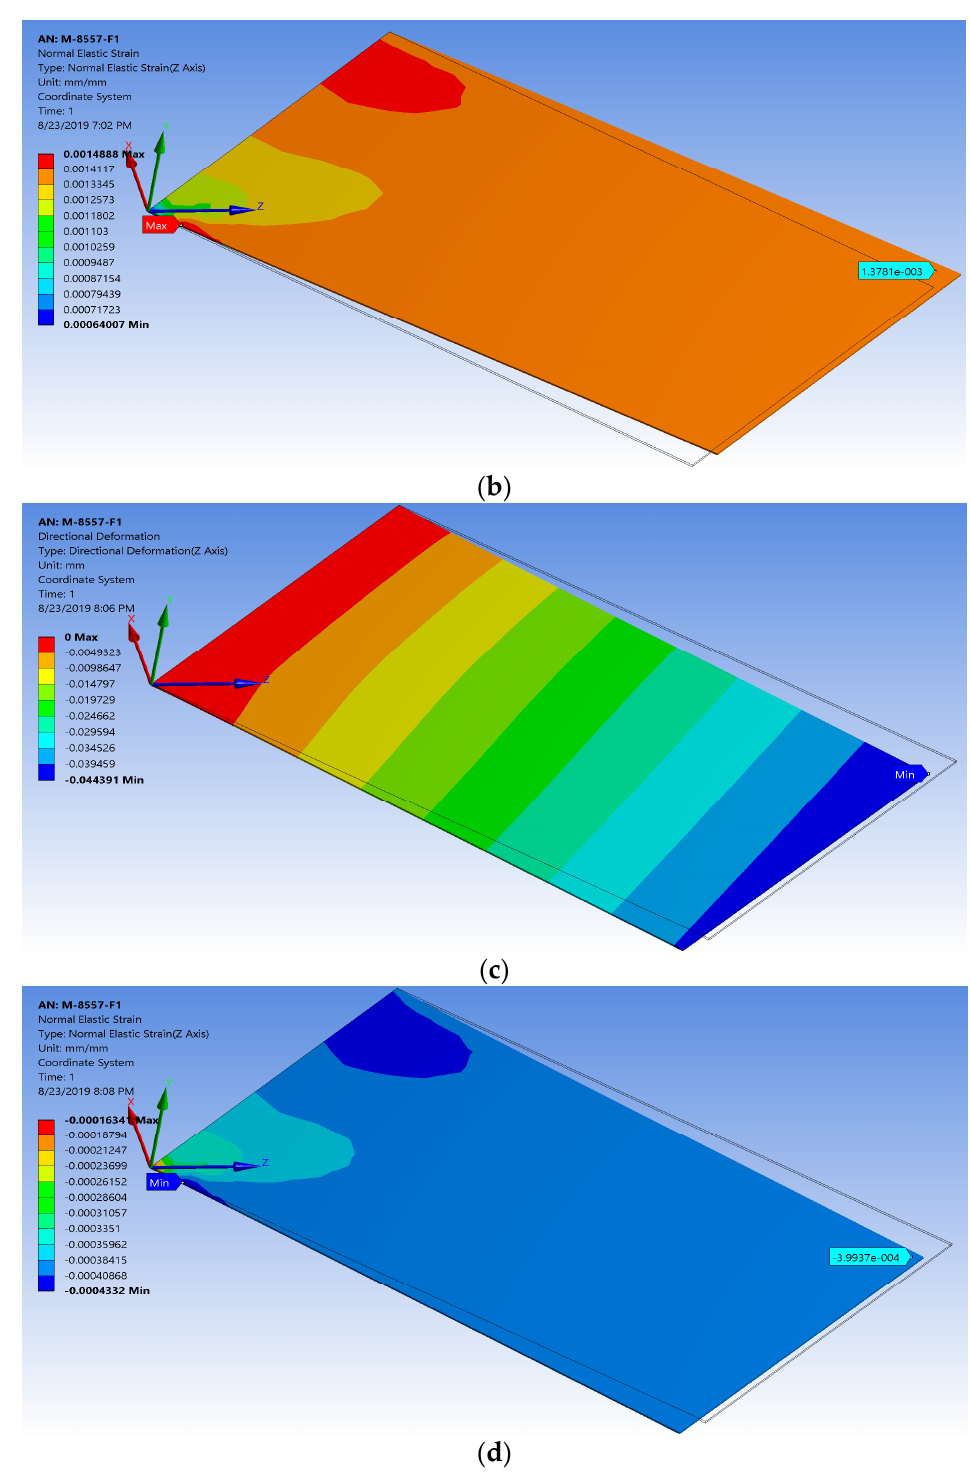
Figure 8. Simplified FE model of M-8557-F1 showing ( a ) the result for elongation displacement in the z -axis, ( b ) the result for max elongation strain, ( c ) the result for compressive displacement in the z -axis, and ( d ) the result for max compressive strain.